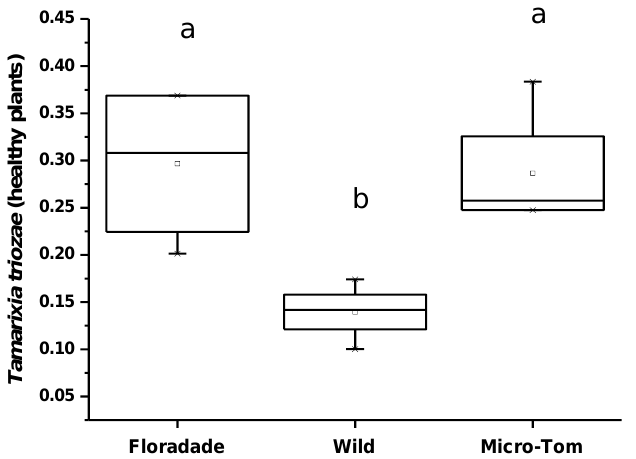
Figure 4. Average number of T. triozae adults attracted to B. cockerelli nymph-free plants of different tomato varieties (Floradade, Wild, and Micro-Tom). Different letters indicate statistical differences ( p < 0.05).